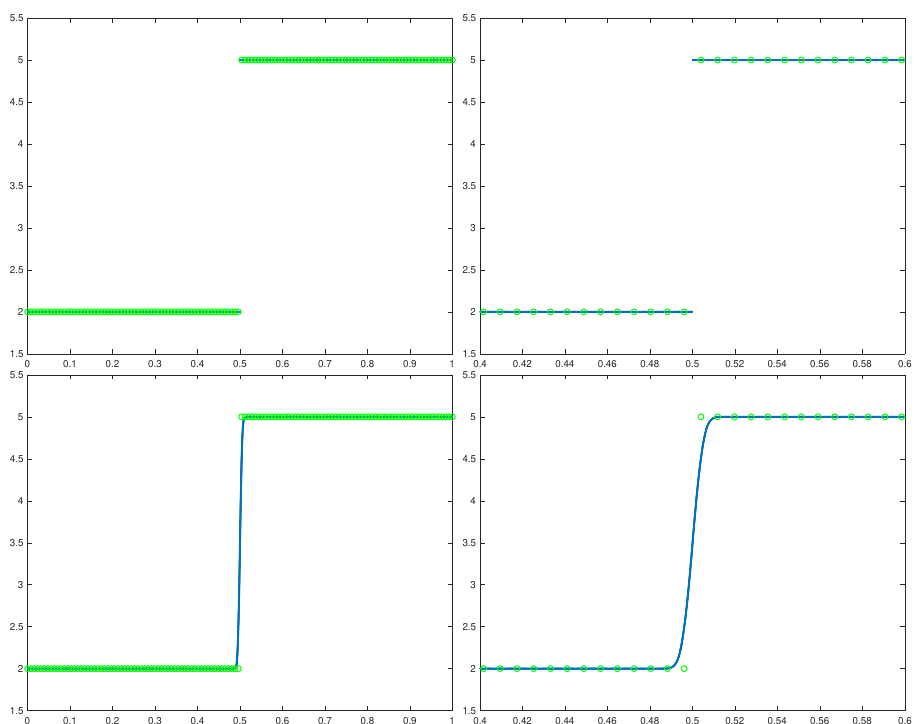
Figure 3. The results obtained for the function in (25) using 10 scales of subdivision. The top left presents the result obtained by the nonlinear version of the three points binary algorithm in (3) and (4). The plot at the top right shows a zoom around the discontinuity. At the bottom of the figure, we can observe the results obtained by the linear algorithm in (2). The nonlinear algorithm manages to reproduce piecewise constant functions, while the linear algorithm introduces